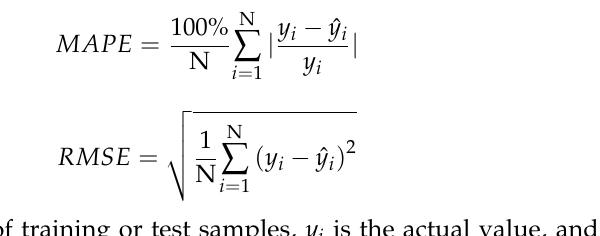
Figure 6. The chart of error–time comparison. As can be seen from Figure 6, the proposed algorithm can complete the power pre- diction within 3 s and greatly shorten the time required for power prediction. In this case, the sampling interval could be further shortened, and the sensitivity of the smoothing system to the power fluctuations in an ultra-short period can be enhanced. Understanding the occupancy of the power prediction in PV power generation sys- tems is of great significance to the internal resource allocation of PV power generation systems. The paper uses AIDA64 software to monitor the computer CPU occupancy rate of each power prediction algorithm when it works. A histogram is used to represent the total occupancy rate of each power prediction algorithm in the PV power generation sys- tem, as shown in Figure 7. The total occupancy rate of the prediction algorithm is the sum of the system occu- pancy rate in each time period when the prediction algorithm is running. The higher its value, the higher the performance requirements of the CPU, and the high total occupancy rate will affect the operation of other parts in the PV power generation system.